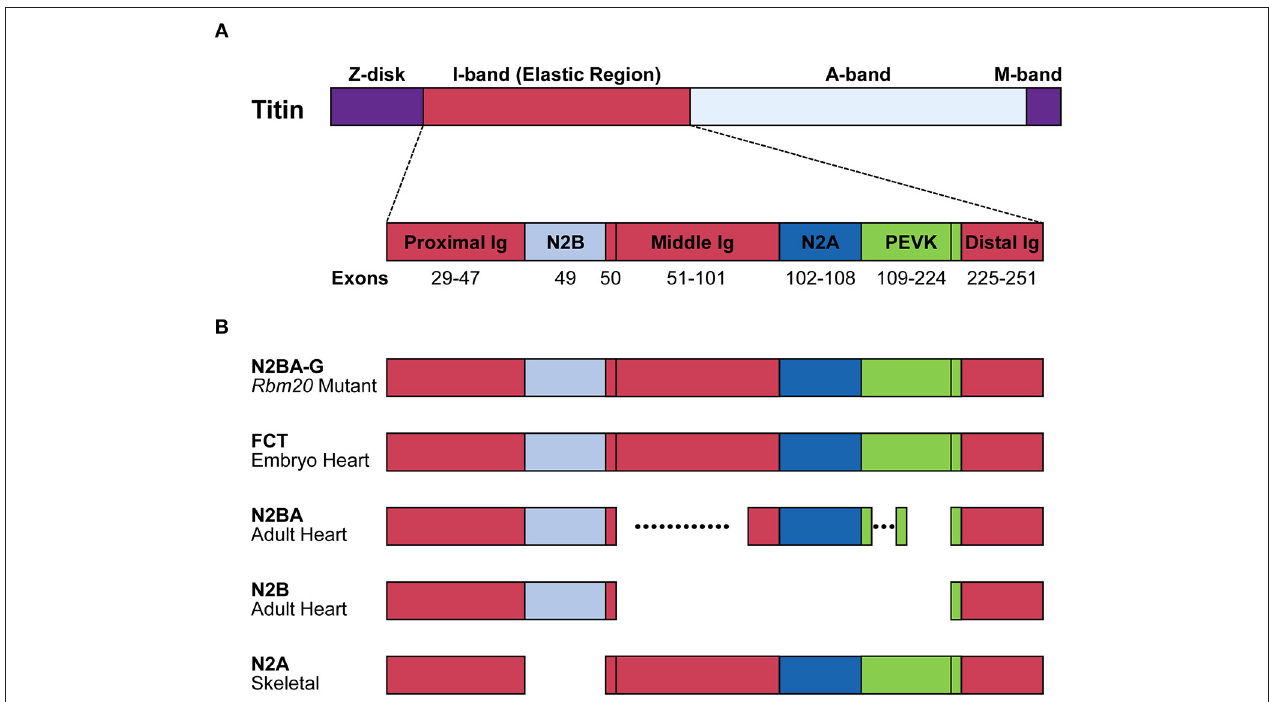
FIGURE 2 | Structure of the titin protein isoforms. (A) Schematic domain structure of the titin protein. Names and positions of the domains are indicated. Corresponding exons are indicated below each domain. Distal Ig, distal Ig repeat domain; Middle Ig, middle Ig repeat domain; N2A, N2A-unique element; N2B,